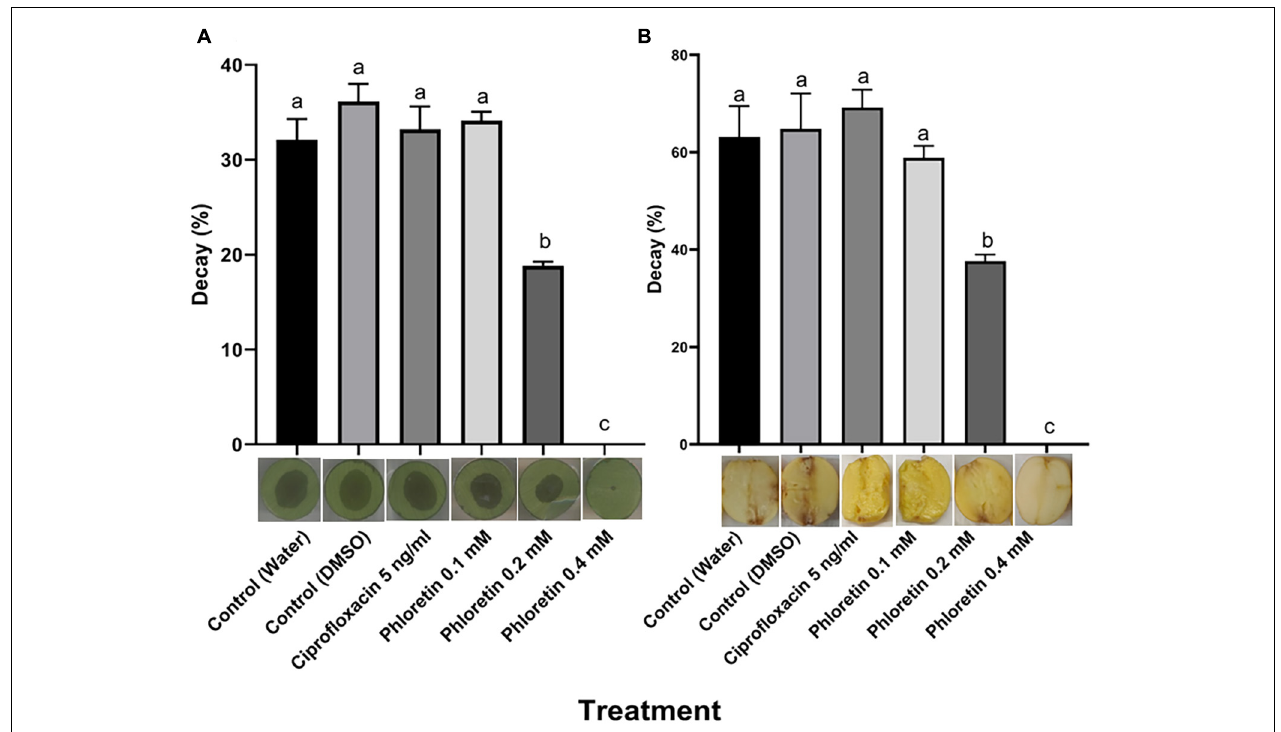
FIGURE 3 | Effects of phloretin on Pectobacterium brasiliense (Pb1692) infection of (A) calla lily leaf discs and (B) potato tubers. Bacterial cultures of Pb1692 were exposed to phloretin or ciprofloxacin, 5 ng/mL (50% growth inhibiting concentration), for 2 h prior to the inoculation of the hosts. Bacterial suspensions were washed and pipetted onto calla lily or potato (10 µ L, 10 6 or 10 5 CFU, respectively) and incubated at 28 ◦ C. The percentage of tissue showing signs of decay was determined at 15 h (calla lily) or 48 h (potato) post-inoculation, relative to a dH 2 O-treated control. DMSO (0.3%) was used as solvent and as an additional control. One-way ANOVA with post hoc Tukey-Kramer HSD tests was used to analyze differences. Bars represent the percentage of necrotic area with standard errors ( n = 20 for calla lily; n = 8 for potato). Bars that are not labeled with the same letter are significantly different from each other ( P < 0.05). Data represent one of two independent experiments with similar results. Representative photographs of infected calla lily leaf discs or potato tubers are provided for each